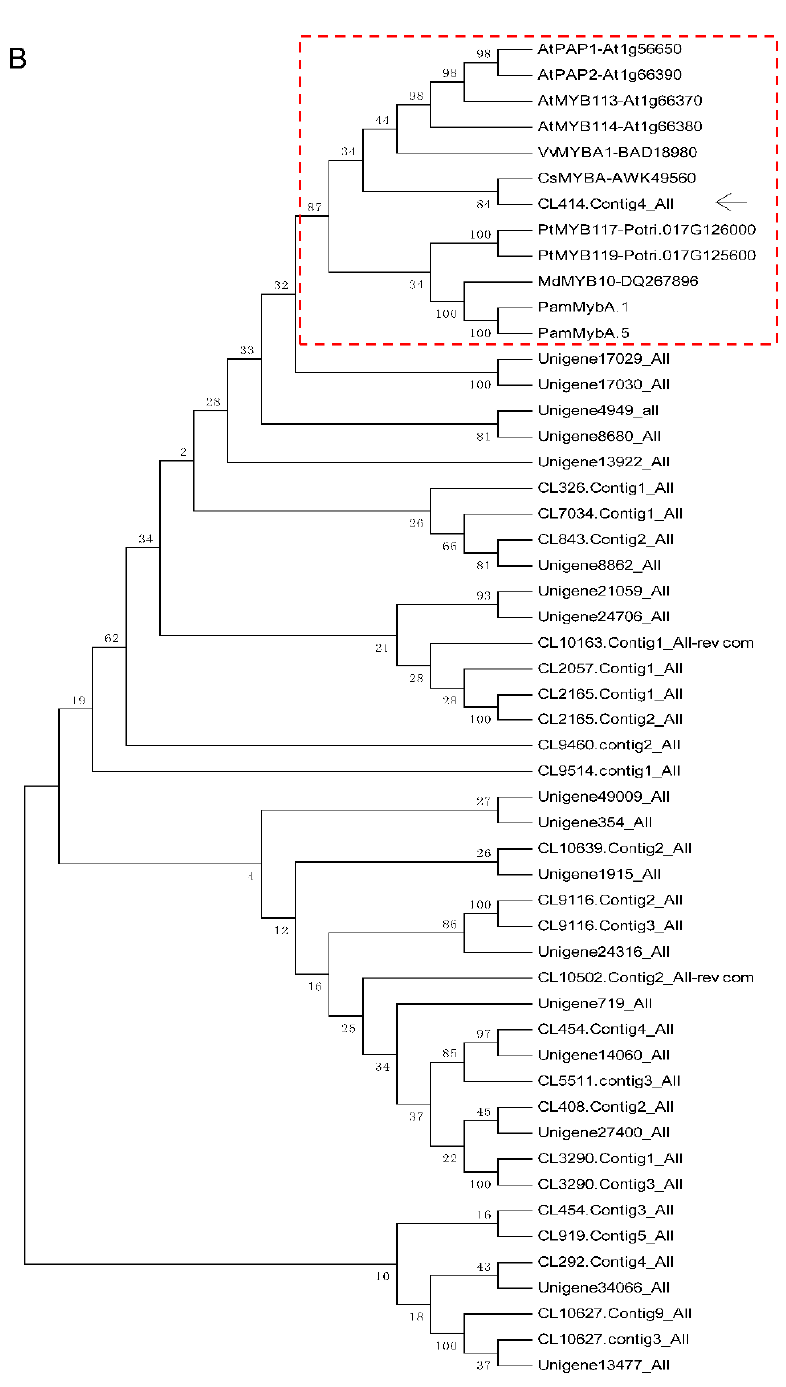
Figure 3. Putative TF families encoded by differentially expressed transcripts and phylogenetic analysis of MYB sequences. ( A ) Annotated TF families of differentially expressed transcripts putatively encoding transcription factors. ( B ) Phylogenetic analysis of deducted peptide sequences of Acer palmatum 42 differentially expressed MYB transcripts and 11 reference MYBs with known function of promoting anthocyanin biosynthesis. The sub-branch of phylogenetic tree containing 11 reference MYBs and one Acer palmatum MYB (CL414.Contig4_All, as indicated by a black arrow, named ApMYB1 thereafter) is enclosed in the dashed rectangle. The intact phylogenetic tree was obtained by aligning peptide sequences of all 42 differentially expressed MYB transcripts with eleven reference MYBs with known function of promoting flavonoid/anthocyanin biosynthesis in Arabidopsis thaliana (At), Vitis vinifera (Vv), Malus domestica (Md), Citrus sinensis (Cs), Prunus americana (Pam) and Populus trichocarpa (Pt).